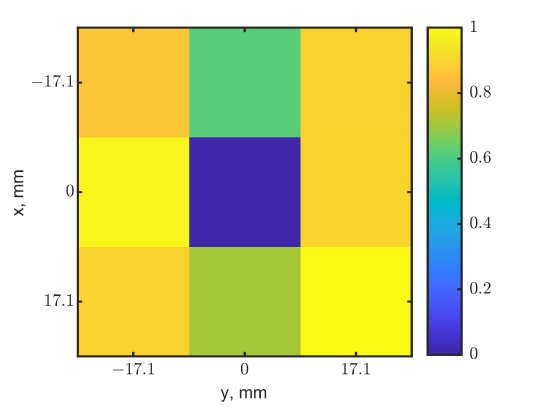
Figure 15. Heatmap from measurements with a tumor of 17.1 3 mm 3 located at (0, 0) with a depth of 10 mm.